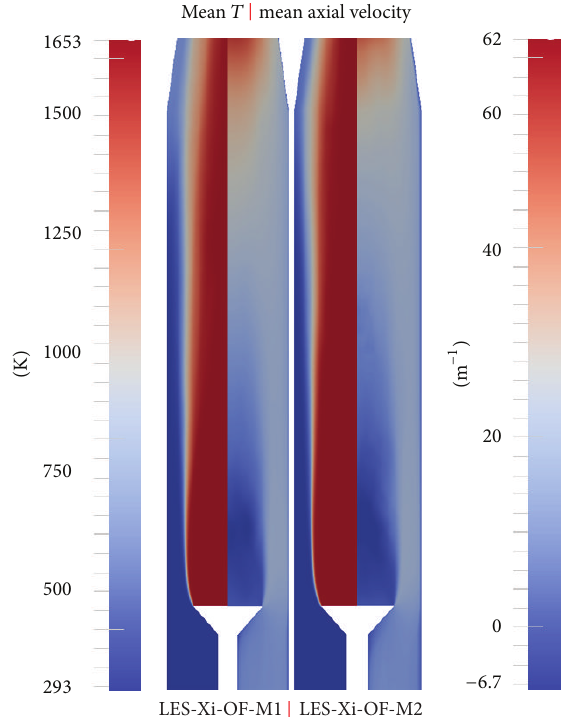
Figure 16: Mean temperature and axial velocity with OpenFOAM (LES).